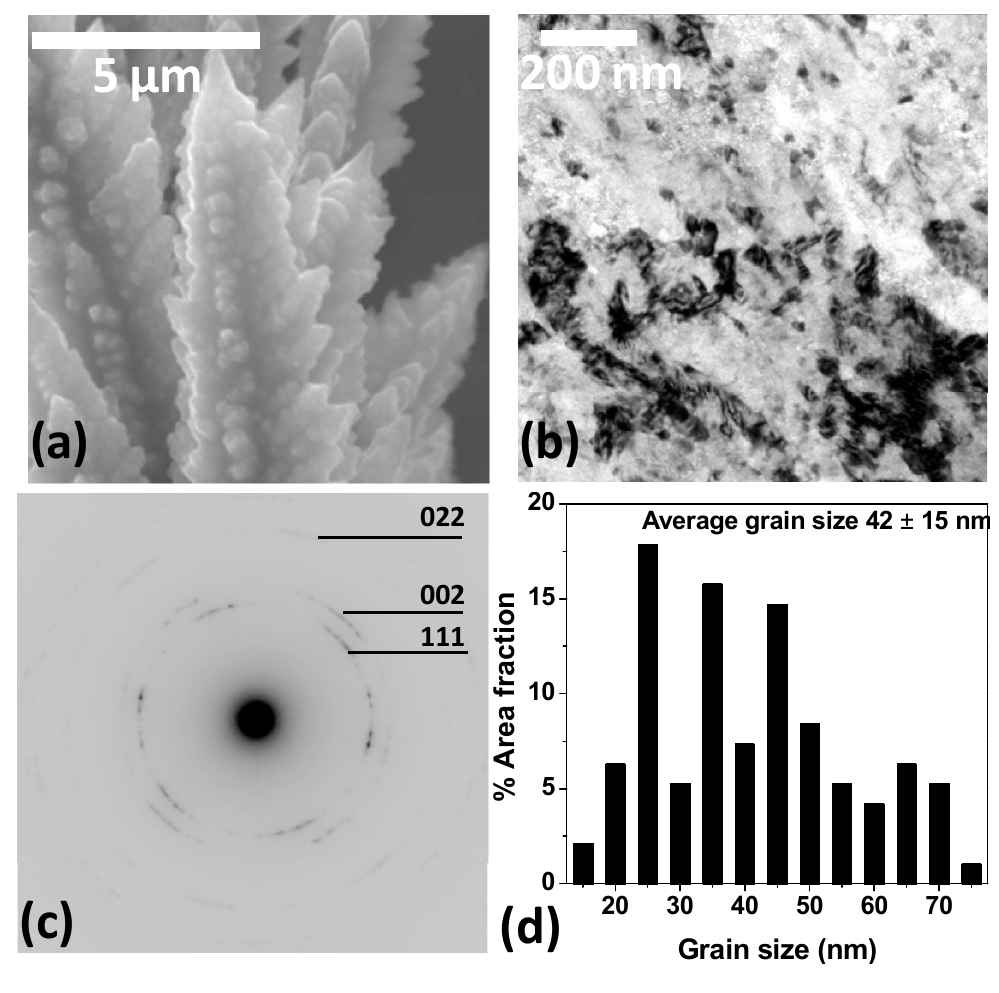
Figure 4. ( a ) SEM image of feather-like morphology; ( b ) Bright Field TEM image of feather-like morphology; ( c ) selected area electron diffraction pattern indicating presence of fcc–Al(Mg) phase ( d ) grain size